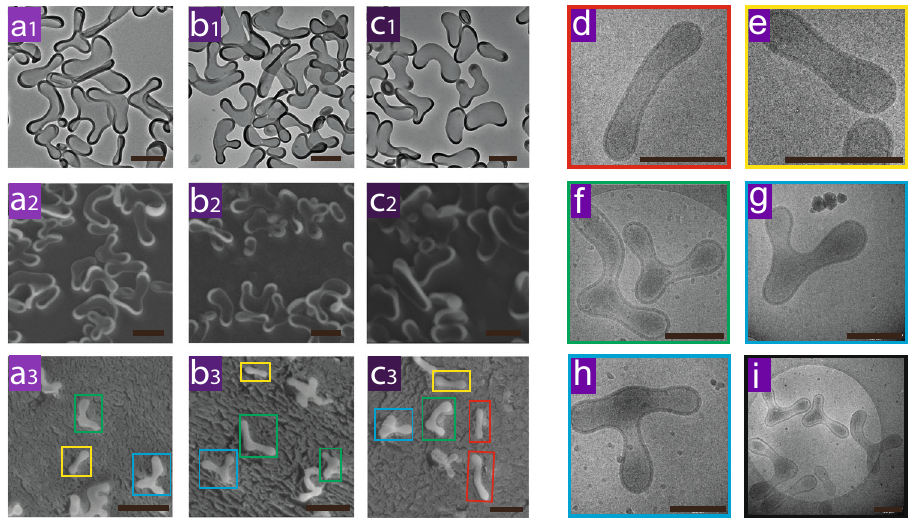
Fig. 3 Polymersome membrane curvature changing with the increase of PNIPAm concentration. a 250 µ g, 500 µ g ( b ) and 1000 µ g ( c )), examined by TEM( b 1- d 1), SEM ( b 2- d 2), Cryo-SEM ( b 3- d 3) and Cryo-TEM ( d – i ), in which nonaxisymmetric polymersomes with cigar-like (red box), rackets-like (yellow